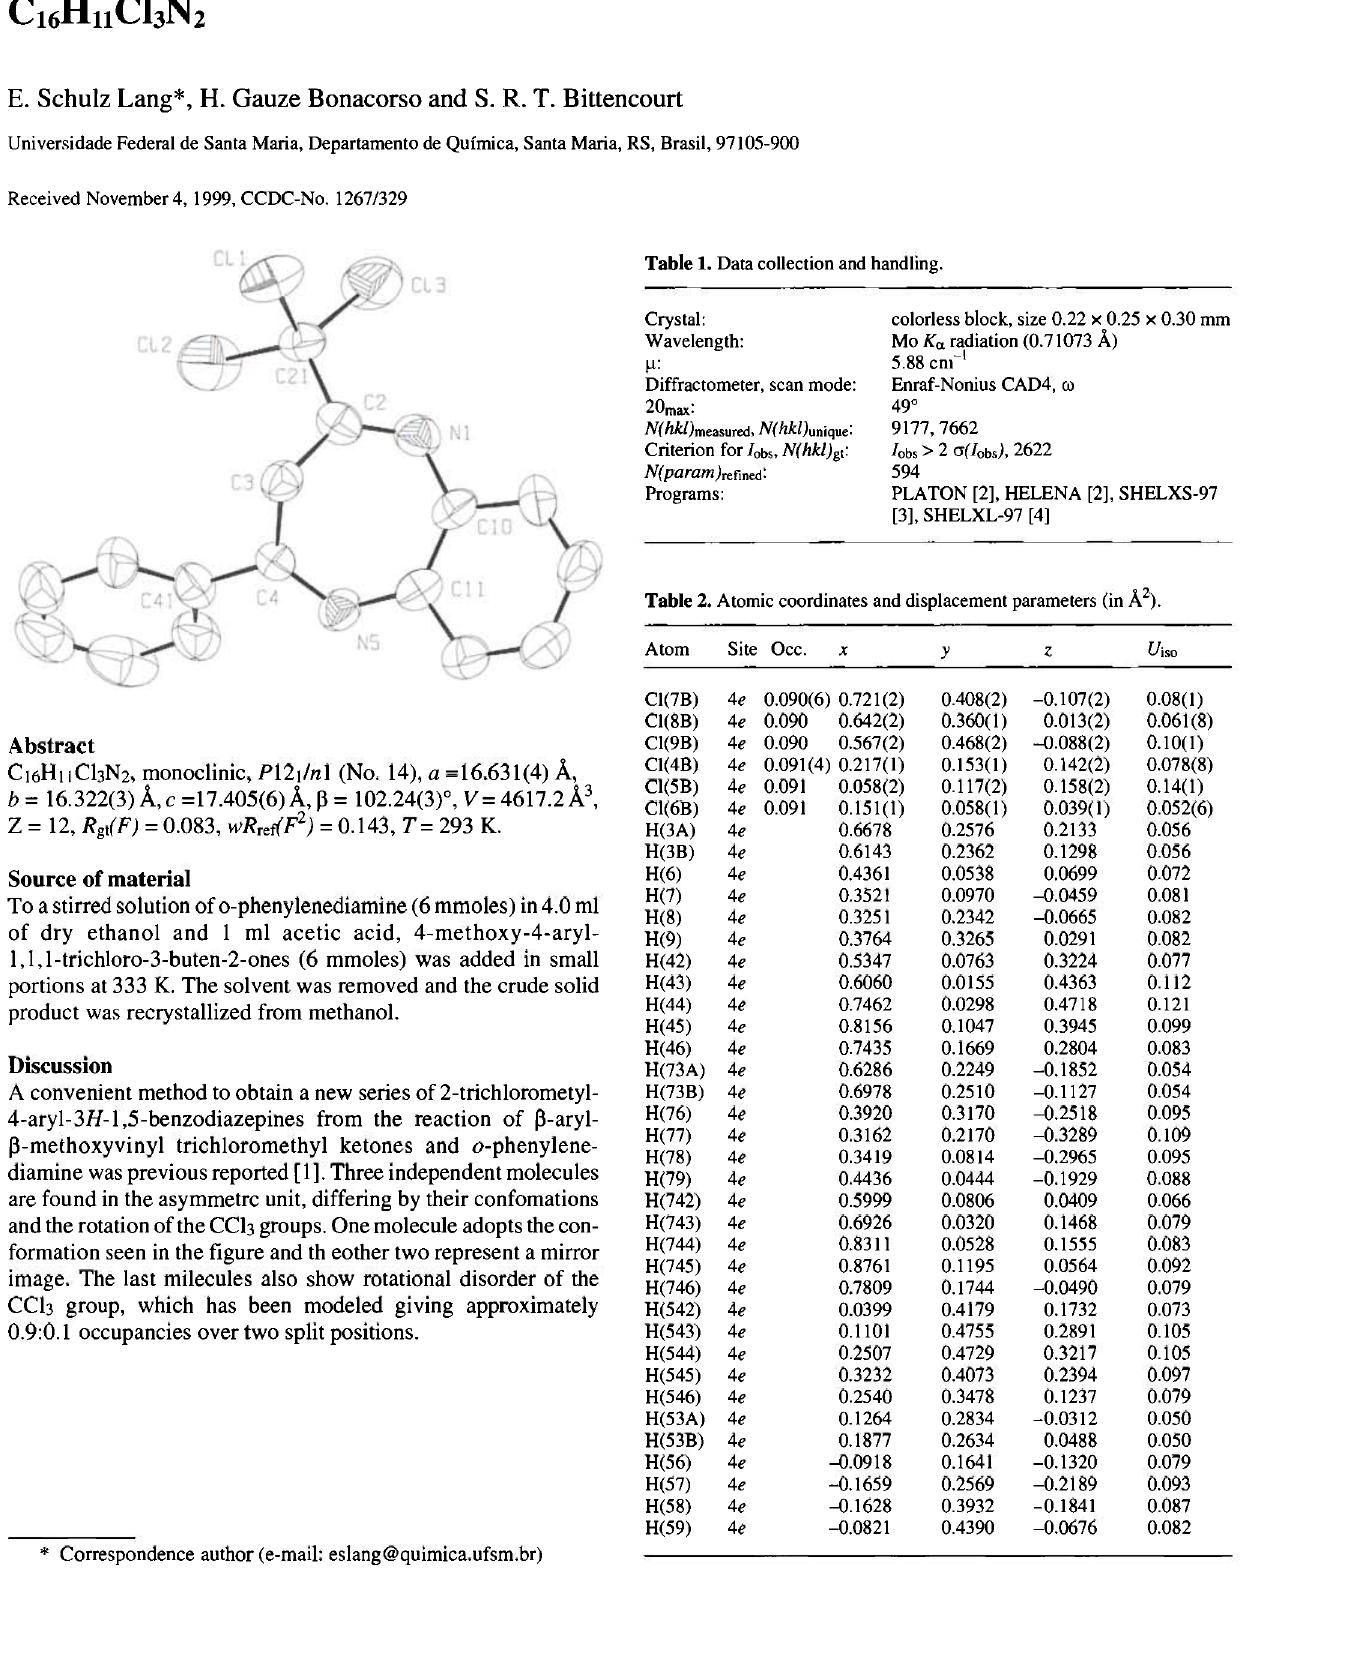
Table 1. Data collection and handling. Crystal: